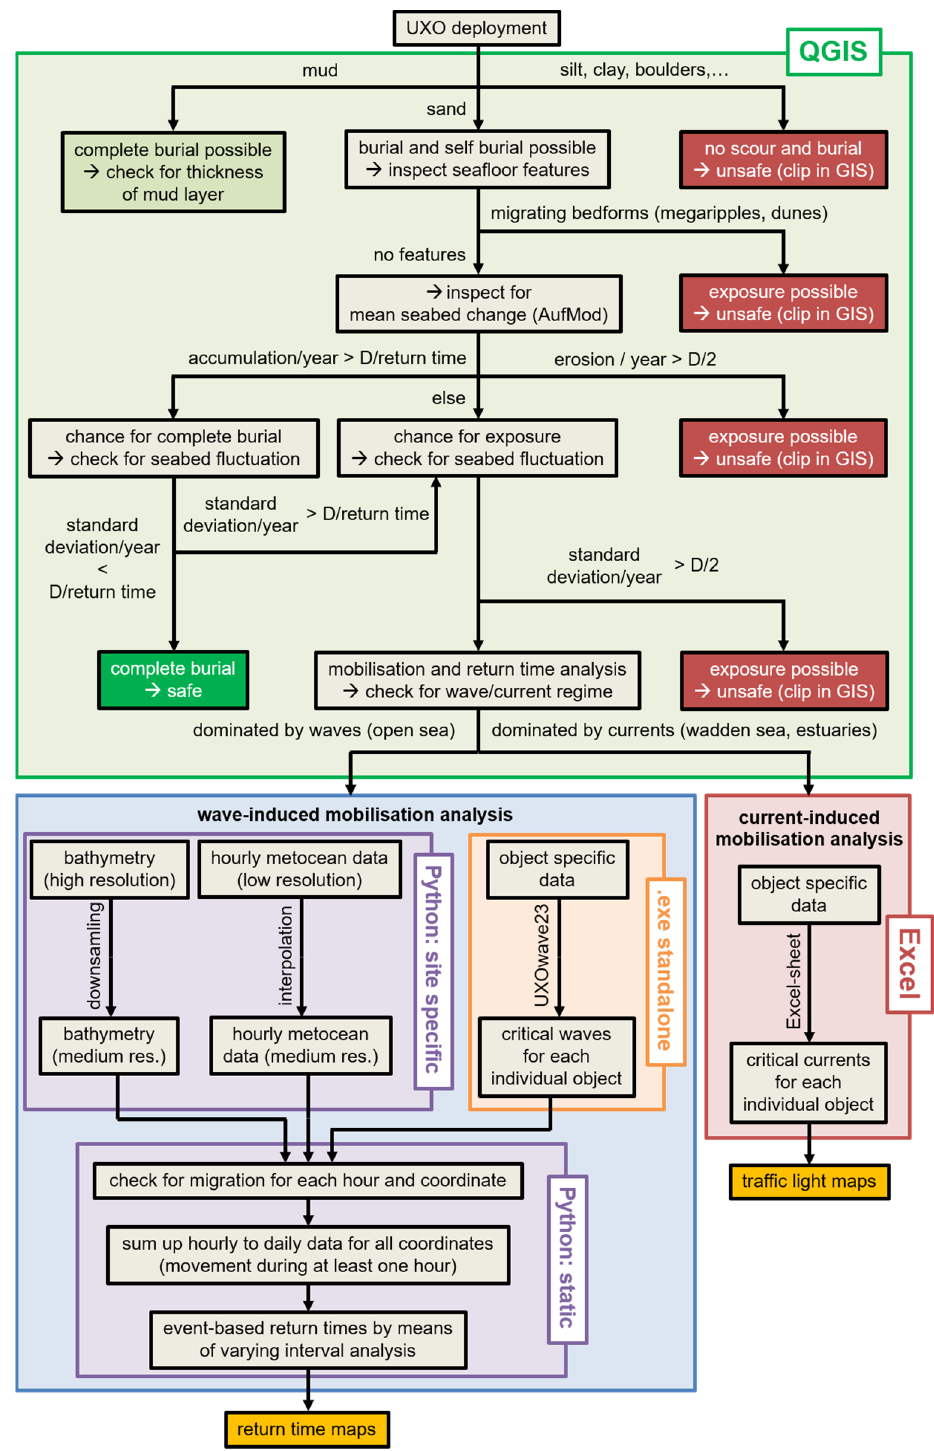
Figure 8. Steps of data processing.